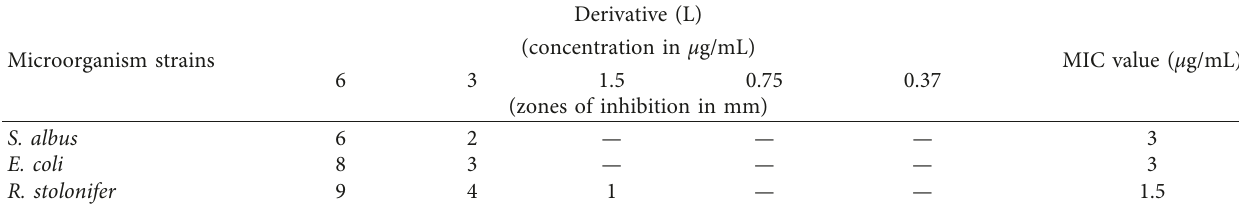
Microorganism strains